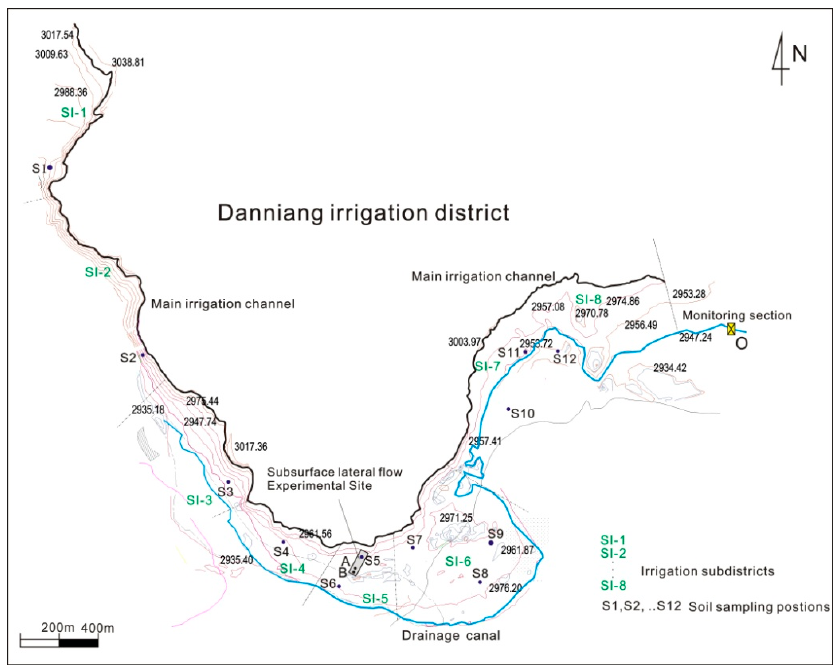
Figure 1. Irrigation and drainage system, sampling positions, and experimental site in the Danniang irrigation district.